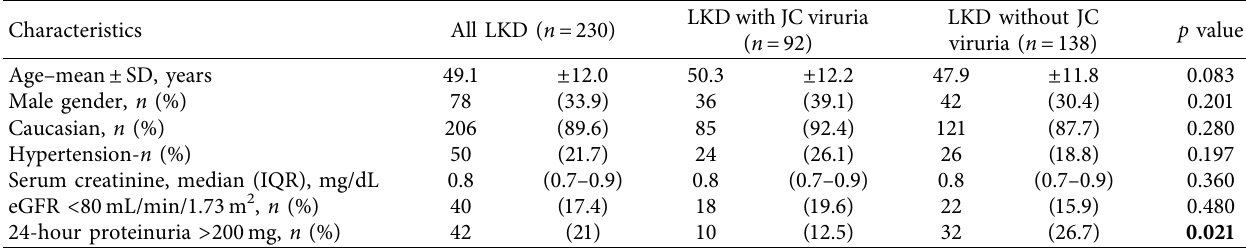
Table 1: Clinical and demographical data of viruric and notviruric living kidney donor candidates Characteristics